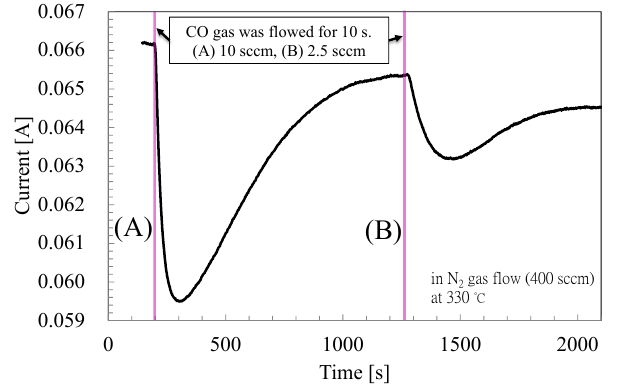
Figure 4. Changes in current in ZnO films at 330 ◦ C due to CO gas. A constant nitrogen gas flow of 400 sccm was used and CO gas was allowed to flow for 10 seconds.